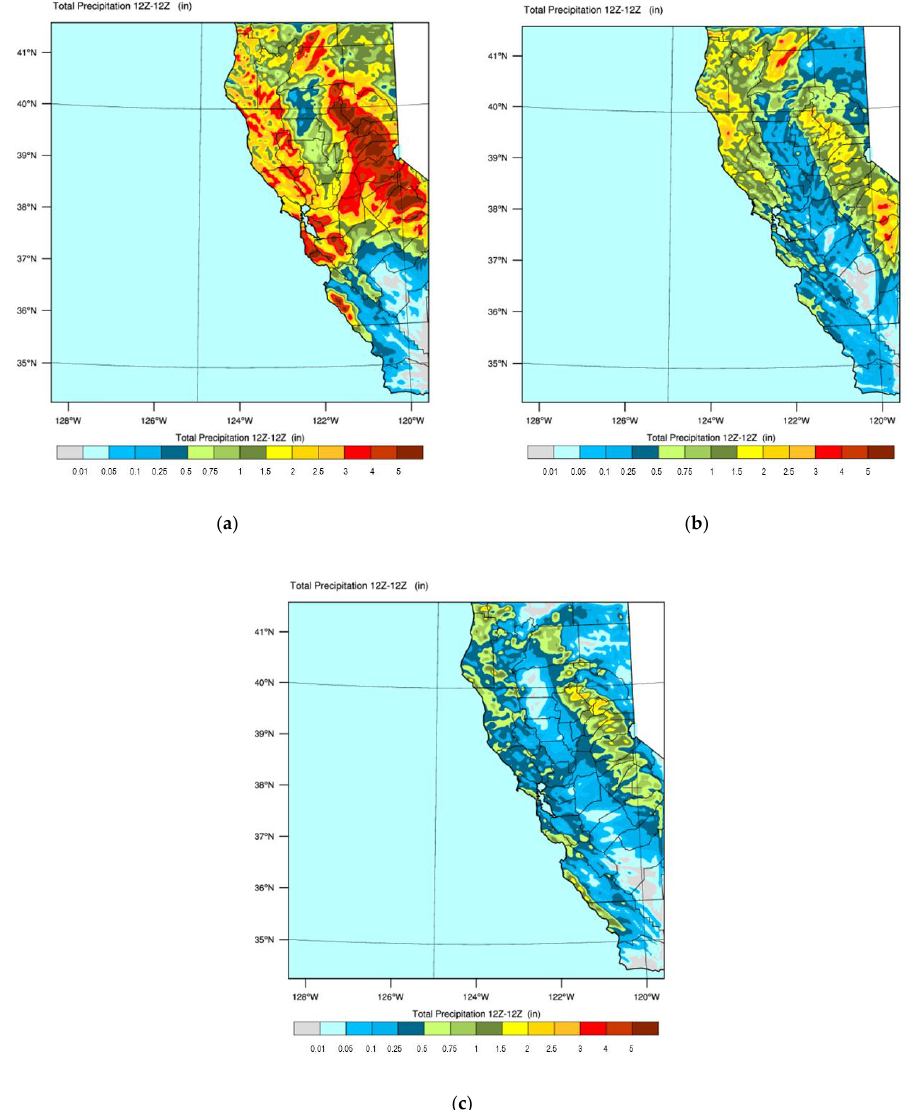
Figure 18. Simulated 24 h accumulated rain (inches) for each case when only a single (4 km) WRF domain is used. ( a ) (upper left) 20 February 2017 case; ( b ) (upper right) 30 October 2016 case; ( c ) (lower middle) 8 December 2016